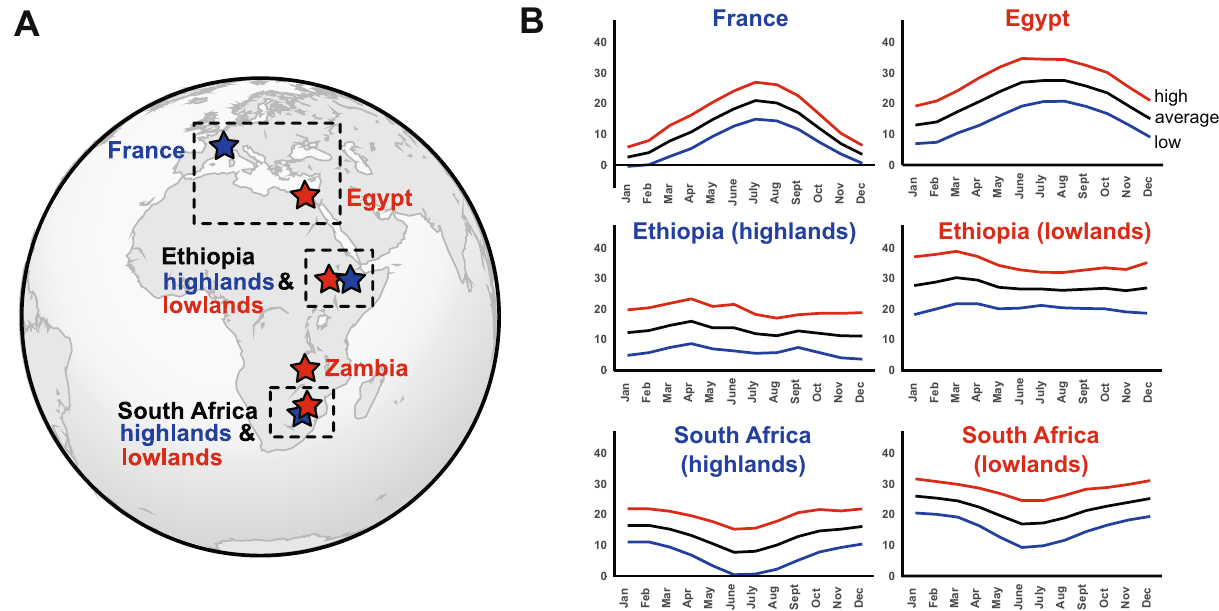
Figure 1. Parallel lines study system. (A) Approximate geographic locations where the progenitors of the laboratory populations were collected, with boxes enclosing paired populations (that are most closely related). See Pool et al. 34 for a neighbour-joining tree showing the relatedness of the populations based on transformed genome-wide average fixation indices. (B) Average monthly highs and lows in the locations where the founder populations of the paired laboratory populations were collected. All climate data was downloaded from climate-